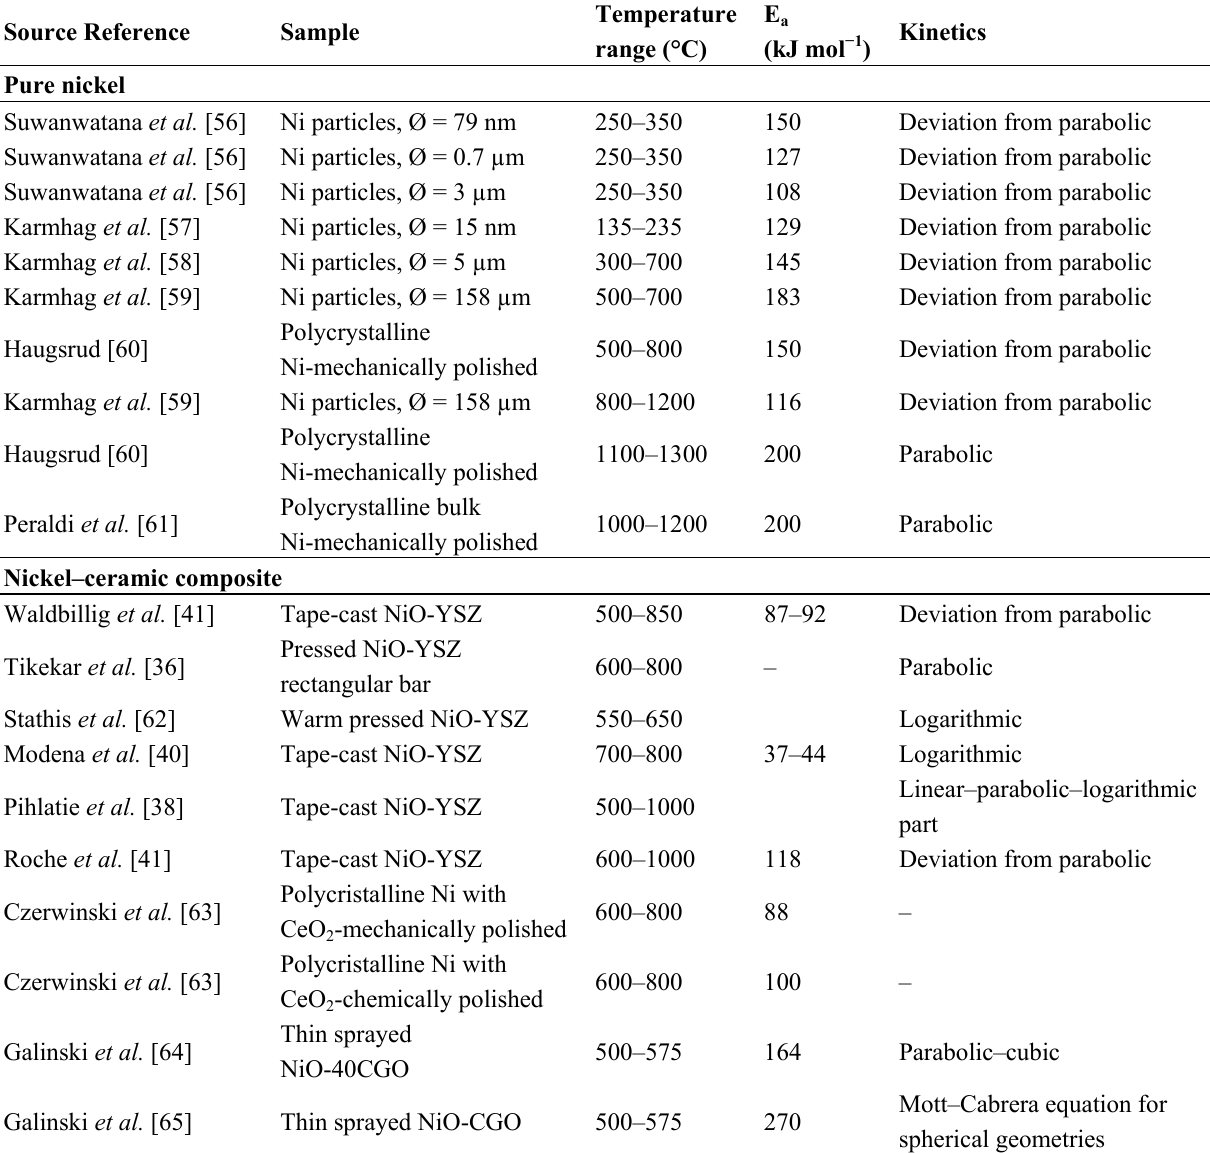
Table 3. Oxidation kinetics of nickel and nickel cermet in air (with Ø for particle